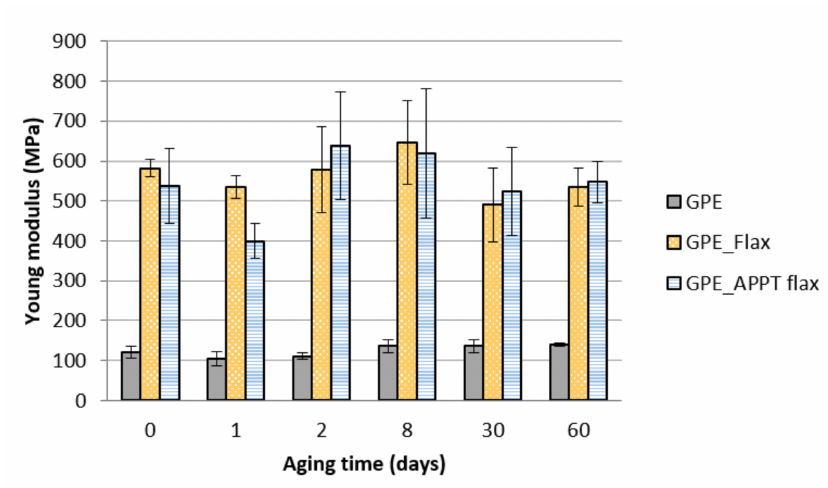
Figure 15. Young’s modulus of GPE materials during aging time.